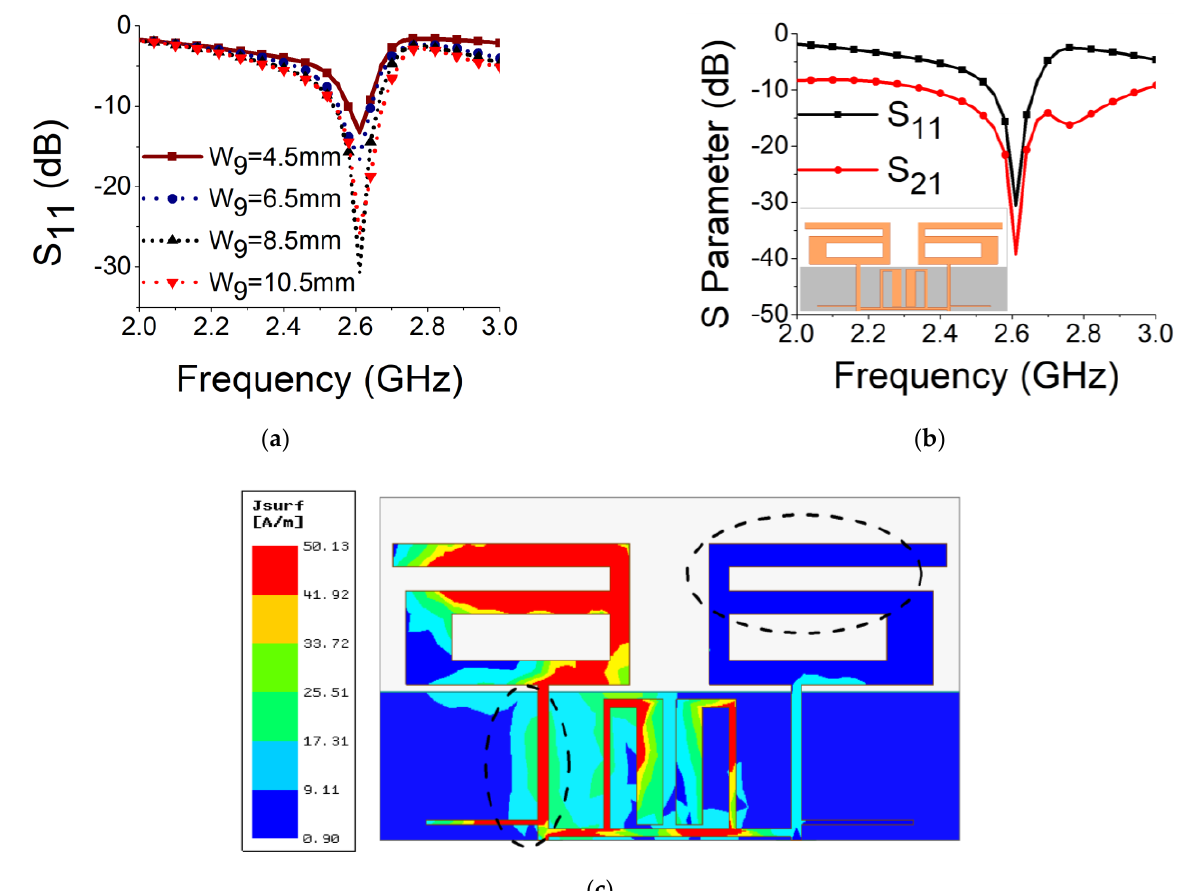
Figure 13. Stub matching network in MIMO antenna: ( a ) effect of W 9 on impedance matching; ( b ) S parameters of final structures; ( c ) current distribution in final structure.